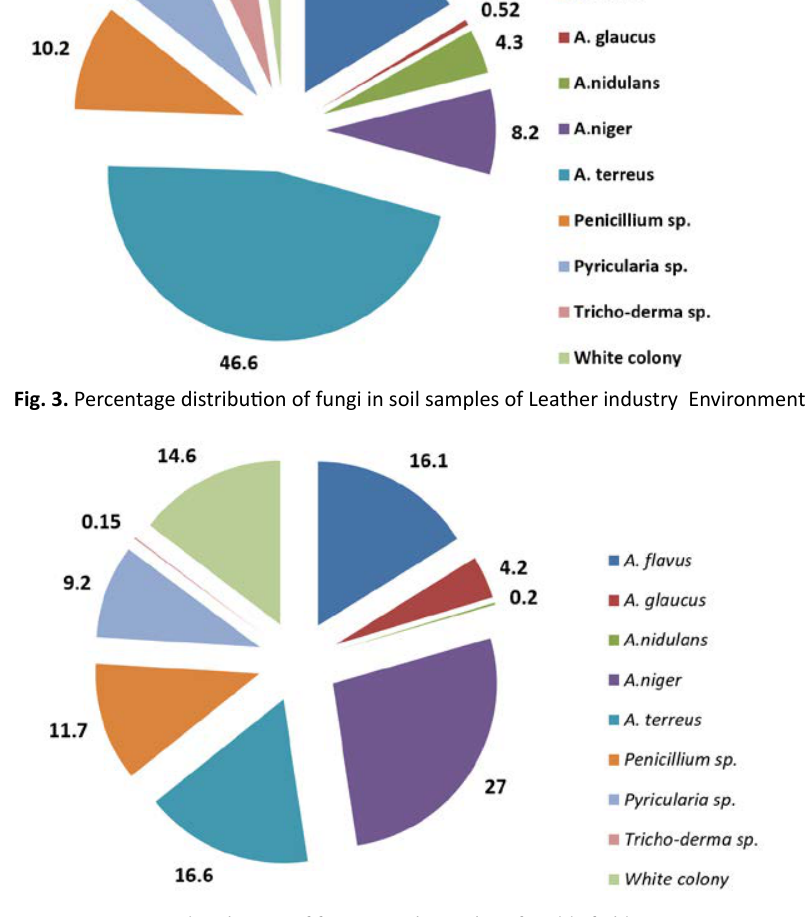
Fig. 4. Percentage distribution of fungi in soil samples of Paddy field